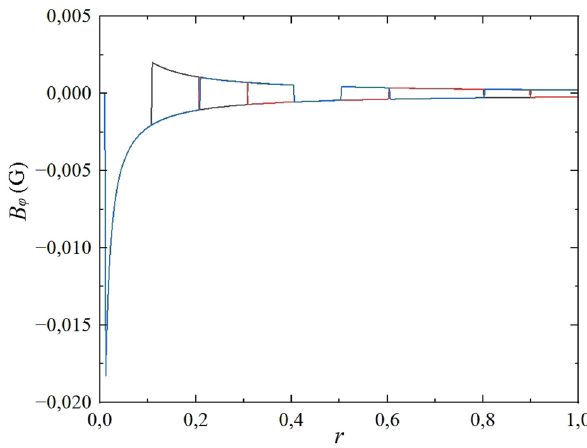
Figure 2: Magnetic fi eld for = t 10 s 7 . Curves with di ff erent colour show di ff erent realizations of random seed fi